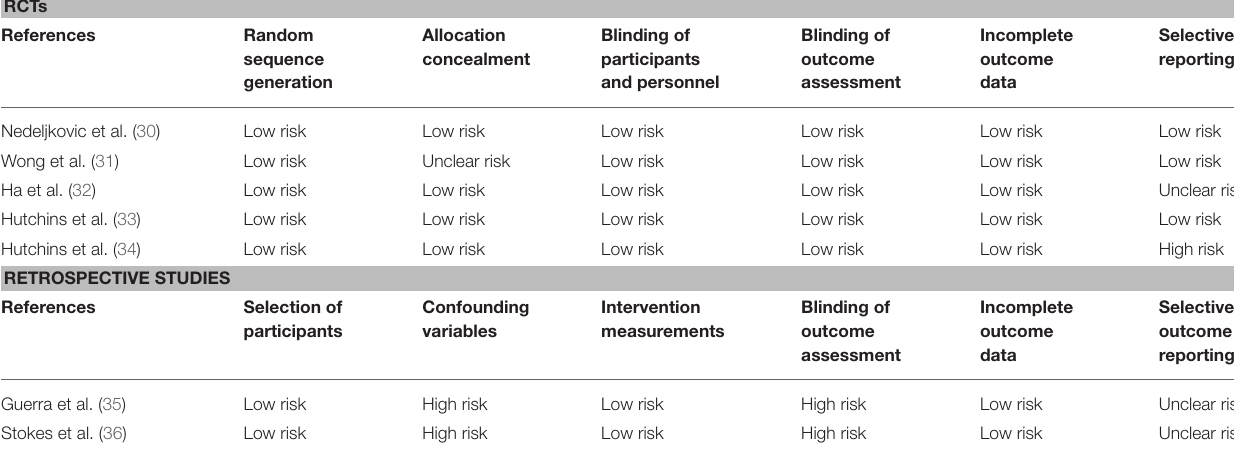
TABLE 4 | Risk of bias in included